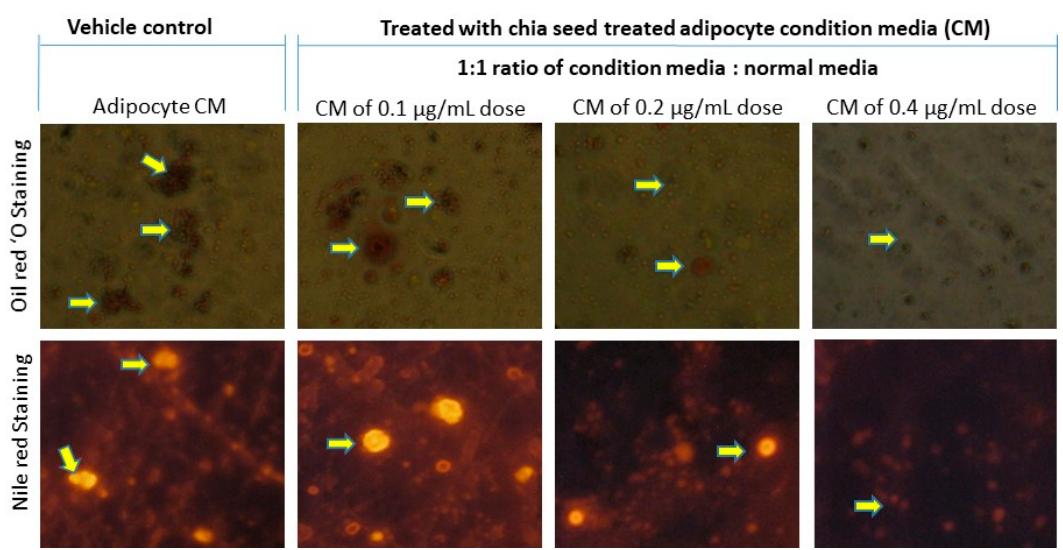
Figure 6. Oil red O and Nile red staining images of different doses of chia seed-treated adipocyte condition media-treated macrophages after 12 h. Foods 2020 , 9 , x FOR PEER REVIEW